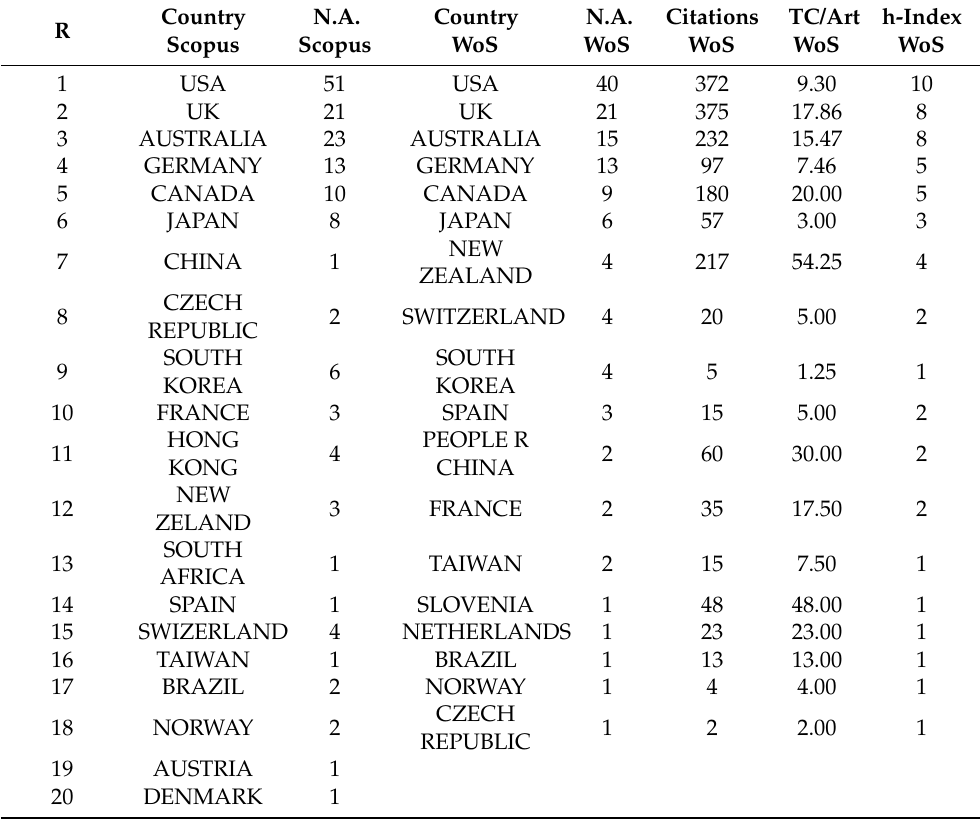
Table 1. Countries by number of publications (Scopus and